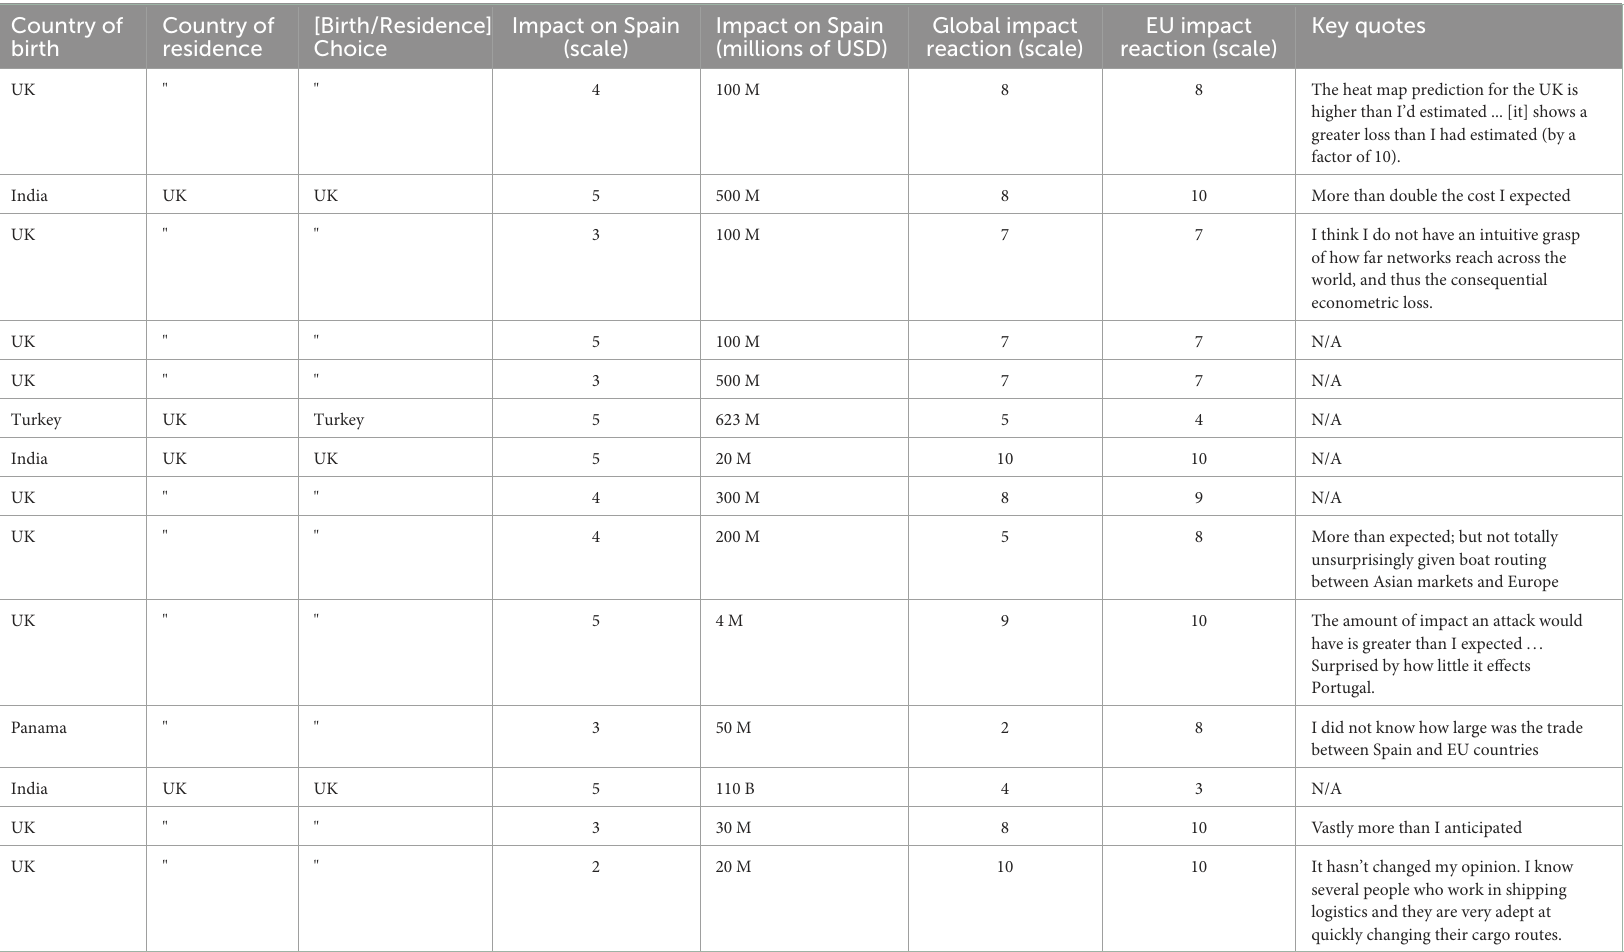
TABLE 2 Simplified replies to